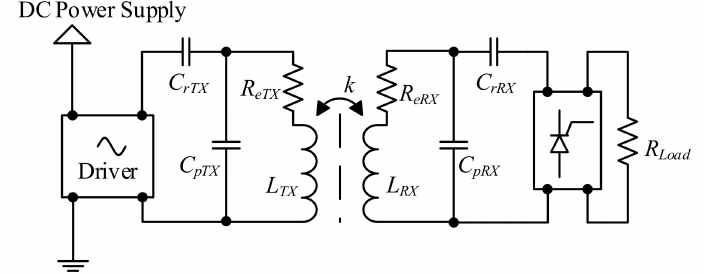
Figure 1. System diagram of wireless inductive power transmission